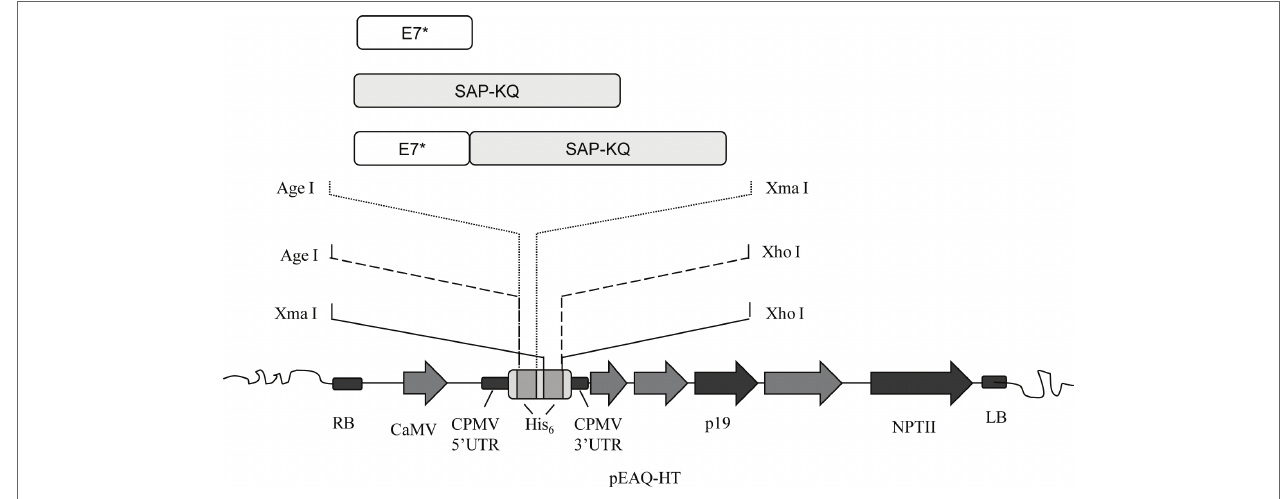
FIGURE 1 | E7GGG (E7*), SAP-KQ, and E7*-SAPKQ genes were inserted in pEAQ-HT for both transient and stable plant expression. The expression cassette consisted of the cauliflower mosaic virus (CaMV) 35S promoter, the Cowpea Mosaic Virus (CPMV) 5 ′ and 3 ′ UTRs with the hyper-translatable mutation, the tomato bushy stunt virus posttranscriptional silencing inhibitor (p19), N- and C-terminal His 6 -tag for affinity purification (His 6 ), and the nopaline synthase terminator sequence from A. tumefaciens (NPTII). Genes were cloned between the indicated sites to gain either a N-terminal, C-terminal, or no His 6 -tag after